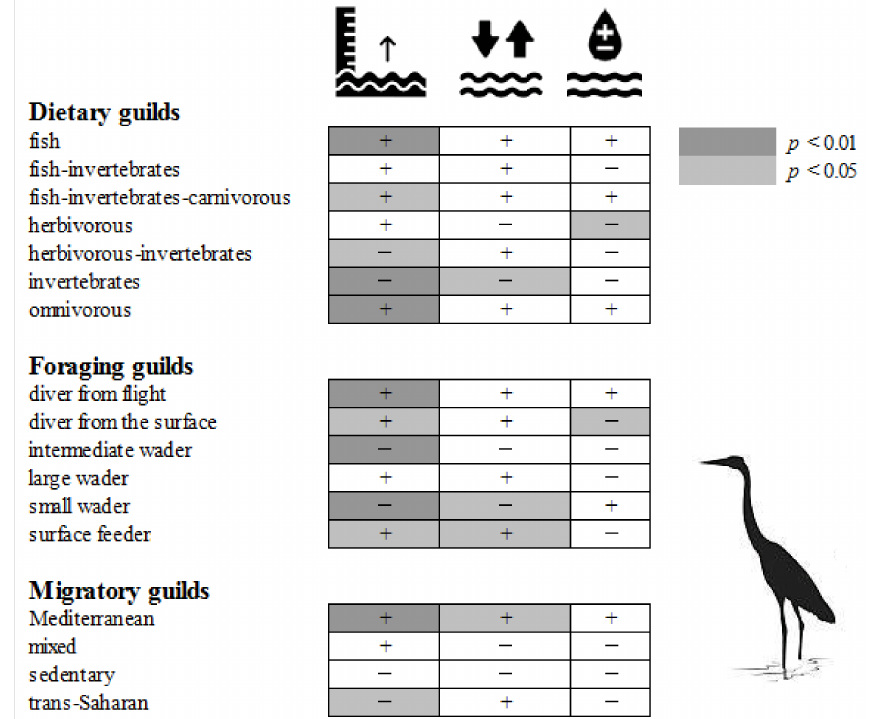
Figure 3. Functional traits (( a ): diet; ( b ): migration; ( c ): foraging) of the avian species sampled in 16 Sicilian wetlands in summer. Numbers in the spider diagrams indicate how many species belong to a particular guild. See Table S3 for a detailed description of the functional traits.